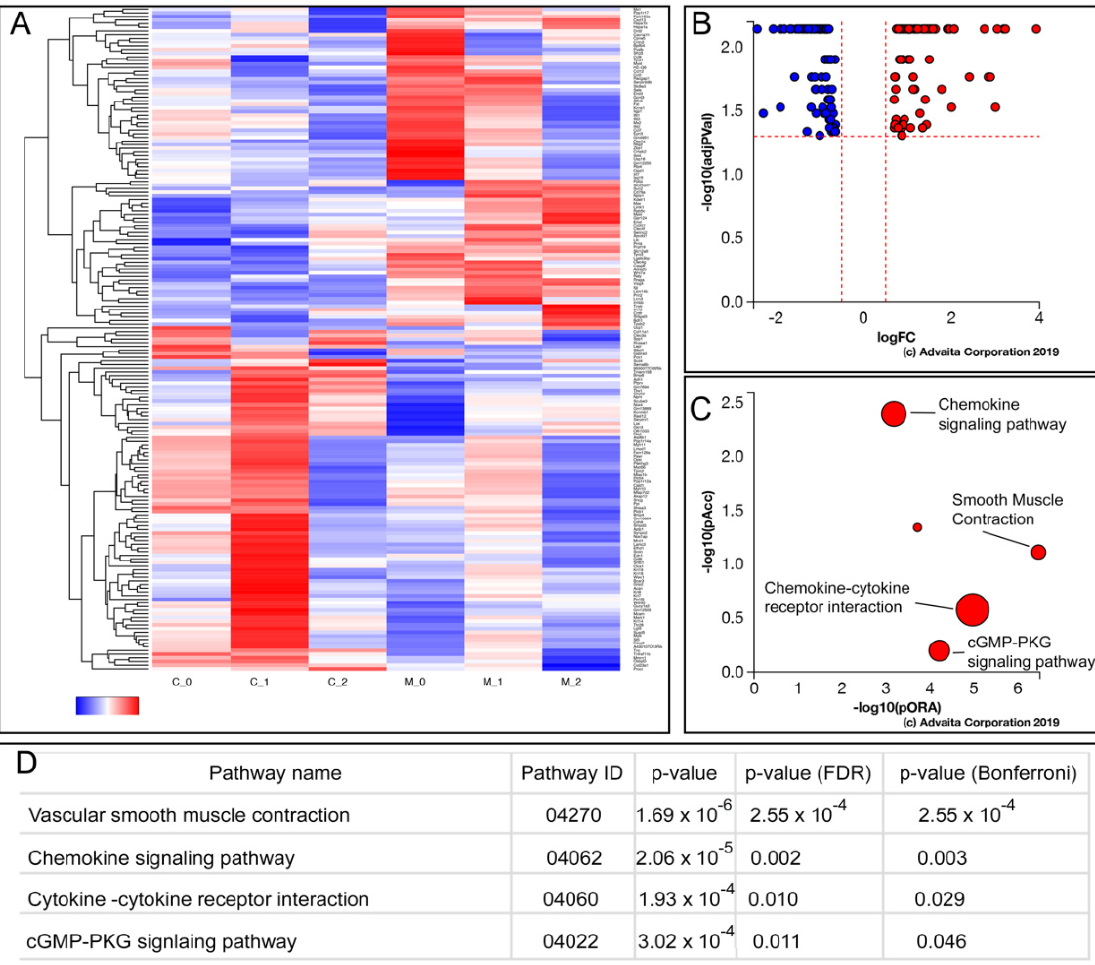
Figure 5. Gene sets associated with smooth muscle cell contraction, chemokine signaling, and cGMP signaling were affected in the caAcvr1:Nfatc1Cre mutants. ( A ) Heat maps of the upregulated and downregulated genes in mutant aortic valve tissues. ( B ) Volcano plot showing all 181 significantly differentially expressed genes in terms of their measured expression change (x-axis) and the significance of the change (y-axis). ( C ) Pathway perturbation vs. over-representation. The top five pathways plotted in terms of the total pathway accumulation (y-axis) and over-representation (x-axis). ( D ) Top pathways and their associated p -values.